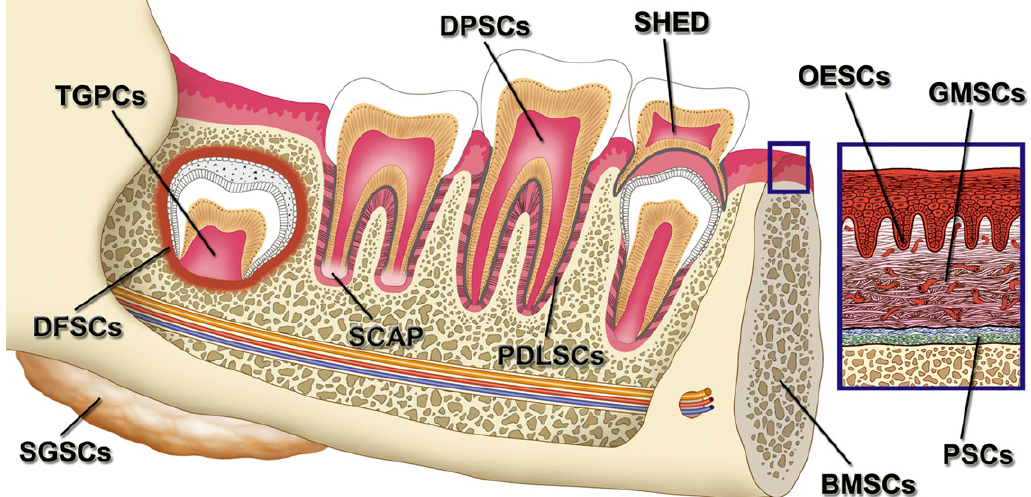
Figure 9. Various stem cell sources within the oral and maxillofacial region. BMSCs: bone marrow-derived MSCs. DPSCs: dental pulp stem cells. SHED: stem cells from human exfoliated deciduous teeth. PDLSCs: periodontal ligament stem cells. DFSCs: dental follicle stem cells. TGPCs: tooth germ progenitor cells. SCAP: stem cells from the apical papilla. OESCs: oral epithelial progenitor/stem cells. GMSCs: gingiva-derived MSCs. PSCs: periosteum-derived stem cells. SGSCs: salivary gland-derived stem cells with permission from Reference [287] .